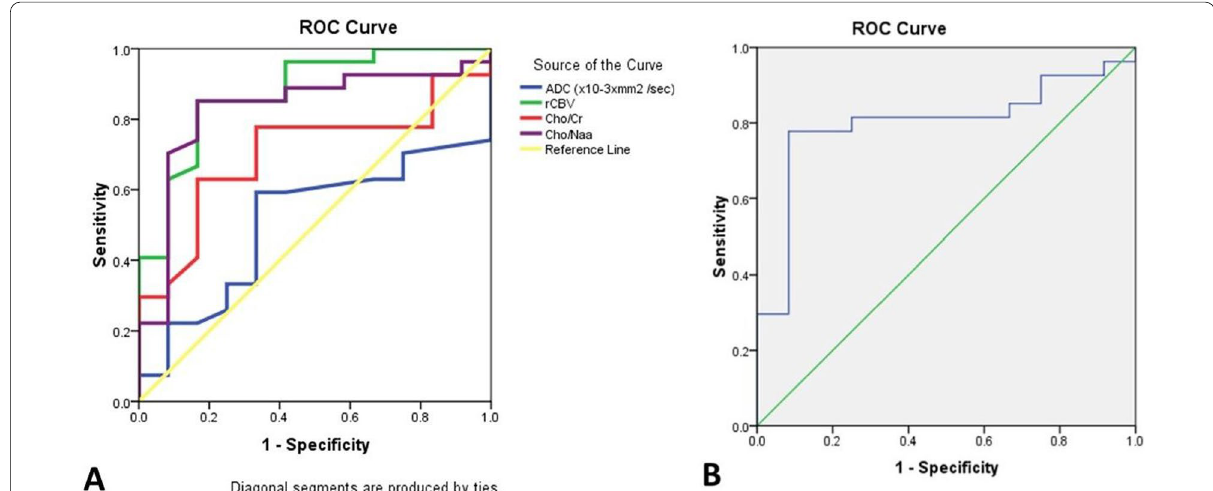
Fig. 1 A Receiver operating characteristic (ROC) curves of apparent diffusion coefficient, relative cerebral blood volume (rCBV), Cho/Cr and Cho/ NAA ratios for differentiating low-grade gliomas from non-neoplastic lesions. B Receiver operating characteristic (ROC) curve of NAA/Cr ratio for differentiating low-grade gliomas from non-neoplastic lesions